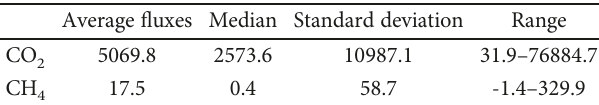
Table 1: Average fl uxes of CH (mg m -2 d -1 ) for 51 measurements in August